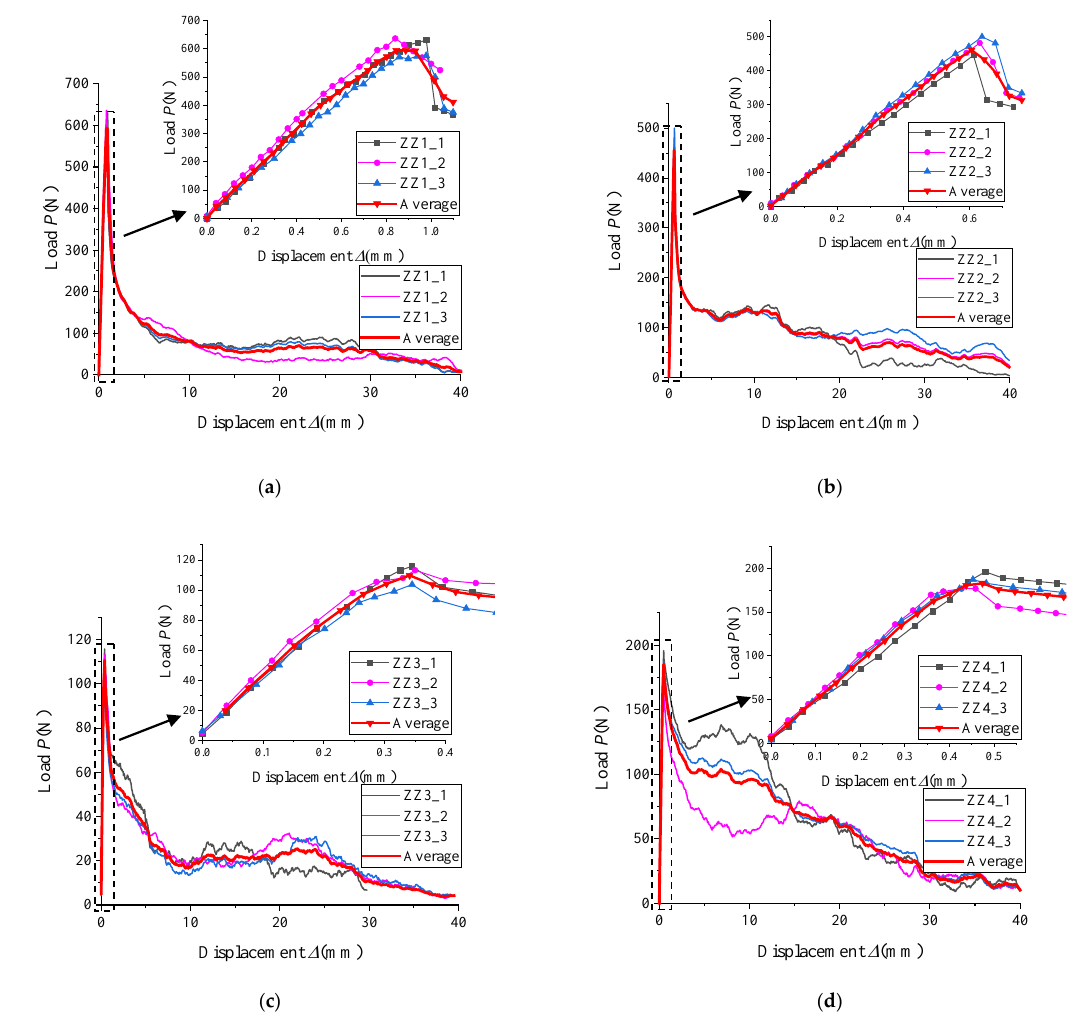
Figure 4. Pullout P - ∆ curves: steel fibres treated by four silane-based coupling agents and Zr(NO 3 ) 4 (group ZZ): ( a ) ZZ1: Z6011 + Zr(NO 3 ) 4 ; ( b ) ZZ2: Z6020 + Zr(NO 3 ); ( c ) ZZ3: Z6030 + Zr(NO 3 ) 4 ; ( d ) ZZ4: Z6040 + Zr(NO 3 ) 4 .